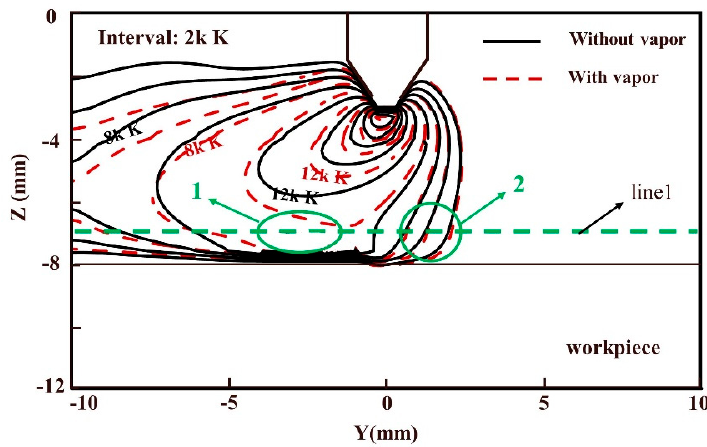
Figure 16. Simulated arc temperature with EMF.